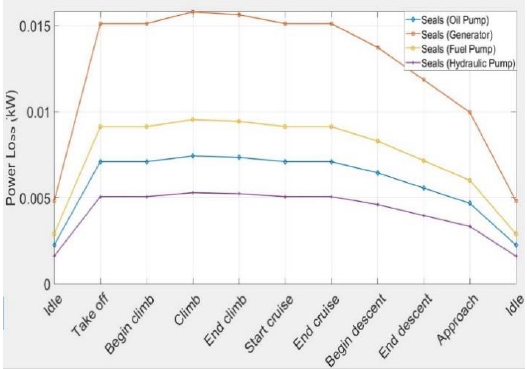
Figure 7. Power losses due to seals friction.